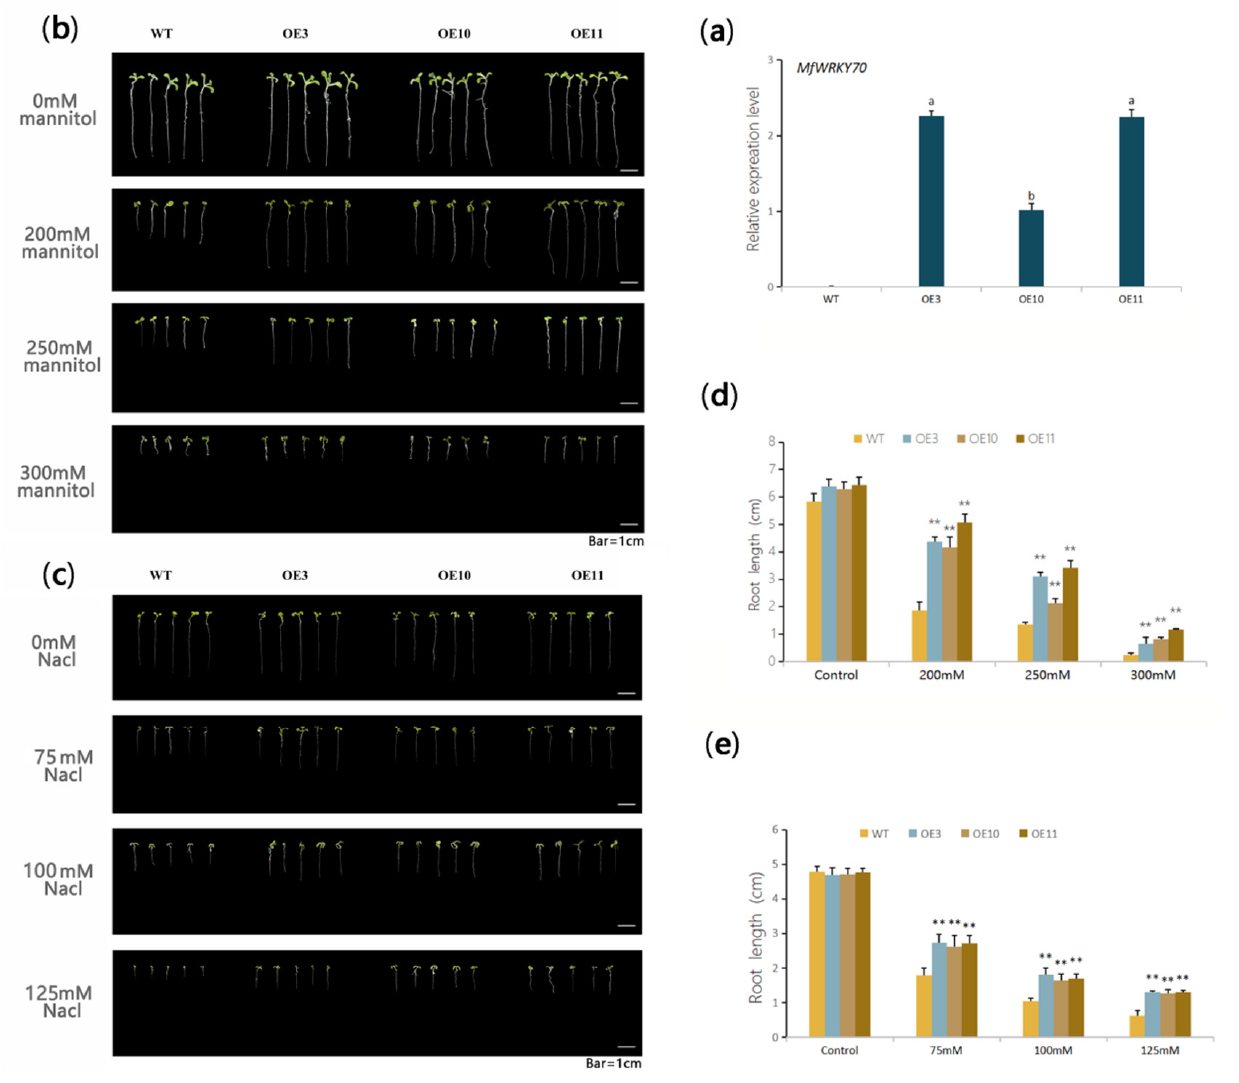
Figure 3. Phenotypic analysis of overexpression (OE) lines and wild type (WT) upon osmotic and salinity stresses at the seedling stage. ( a ) Relative expression levels of MfWRKY70 in OE lines measured by qRT-PCR. Data are presented as mean and SD values of three technical and three biological replicates. Different letters above the columns indicated that the expression levels are significantly different from each other at p < 0.05 (LSD multiple comparison test after ANOVA). ( b , c ) Morphology of OE lines and WT seedlings grown on medium containing different amounts of mannitol and NaCl for one week. ( d , e ) Root length of one-week-old OE lines and WT seedlings containing different amounts of mannitol and NaCl, respectively. Data are presented as mean and SD values of three independent experiments. Asterisks indicate significant difference (** p < 0.01, by Student’s t -test) comparing to WT.